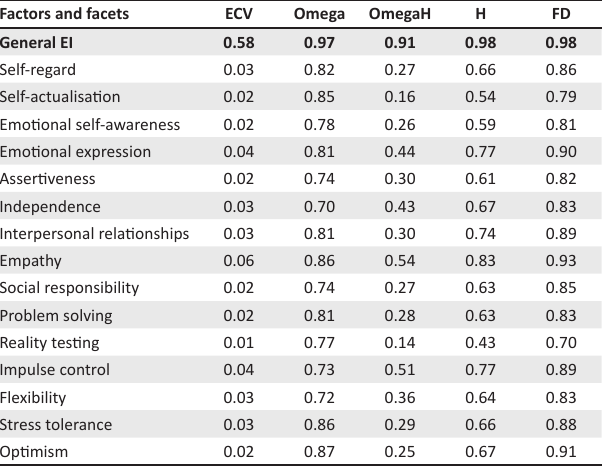
TABLE 4: Total emotional intelligence regressed on general and broad dimensions of individual work performance.